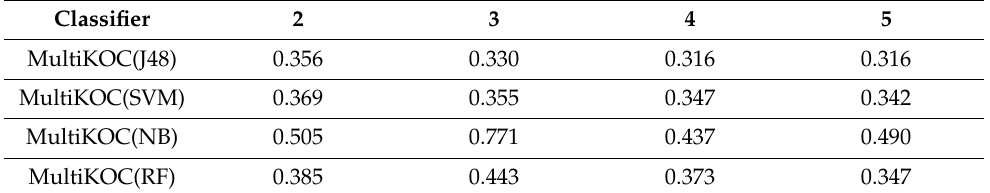
Table 9. Results summary for MultiKOC method with 2, 3, 4, 5 clusters on new thyroid class 1 data.